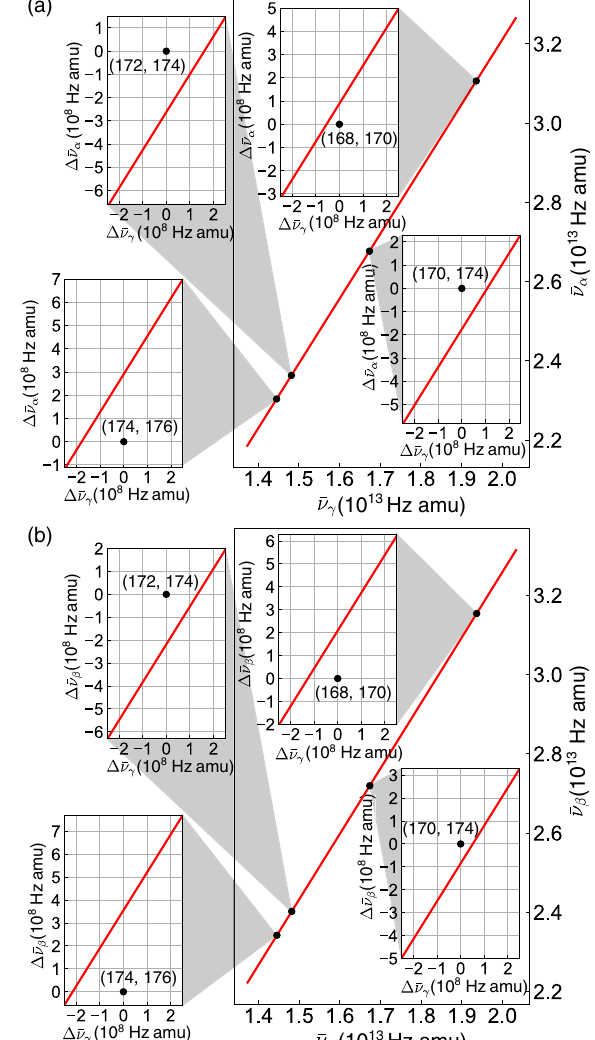
FIG. 6. 2D King plots of γ ∶ Yb 1 S 0 − 3 P 0 transition versus − 2 D β ∶ Yb þ 2 S − 2 D (a) α ∶ Yb þ 2 S 1 5 = 2 transition and (b) 1 = 2 3 = 2 = 2 transition. Each inset shows the enlarged view magnified by 10 5 . Error bars, which represent 1 σ uncertainties, are smaller than the symbol sizes. Solid lines are the fits to the data with Eq.